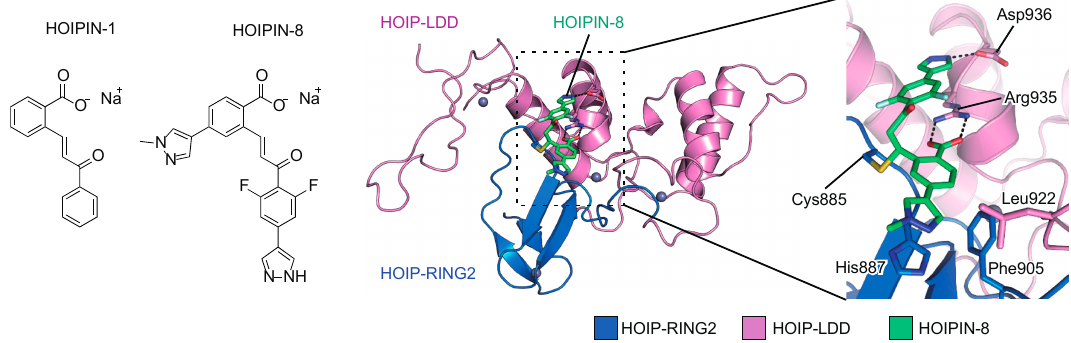
Figure 5. LUBAC inhibitors, HOIPIN-1 and HOIPIN-8. Chemical structures of HOIPIN-1 and -8, and crystal structure of the HOIPIN-8-bound RING2-LDD domain of HOIP are shown.